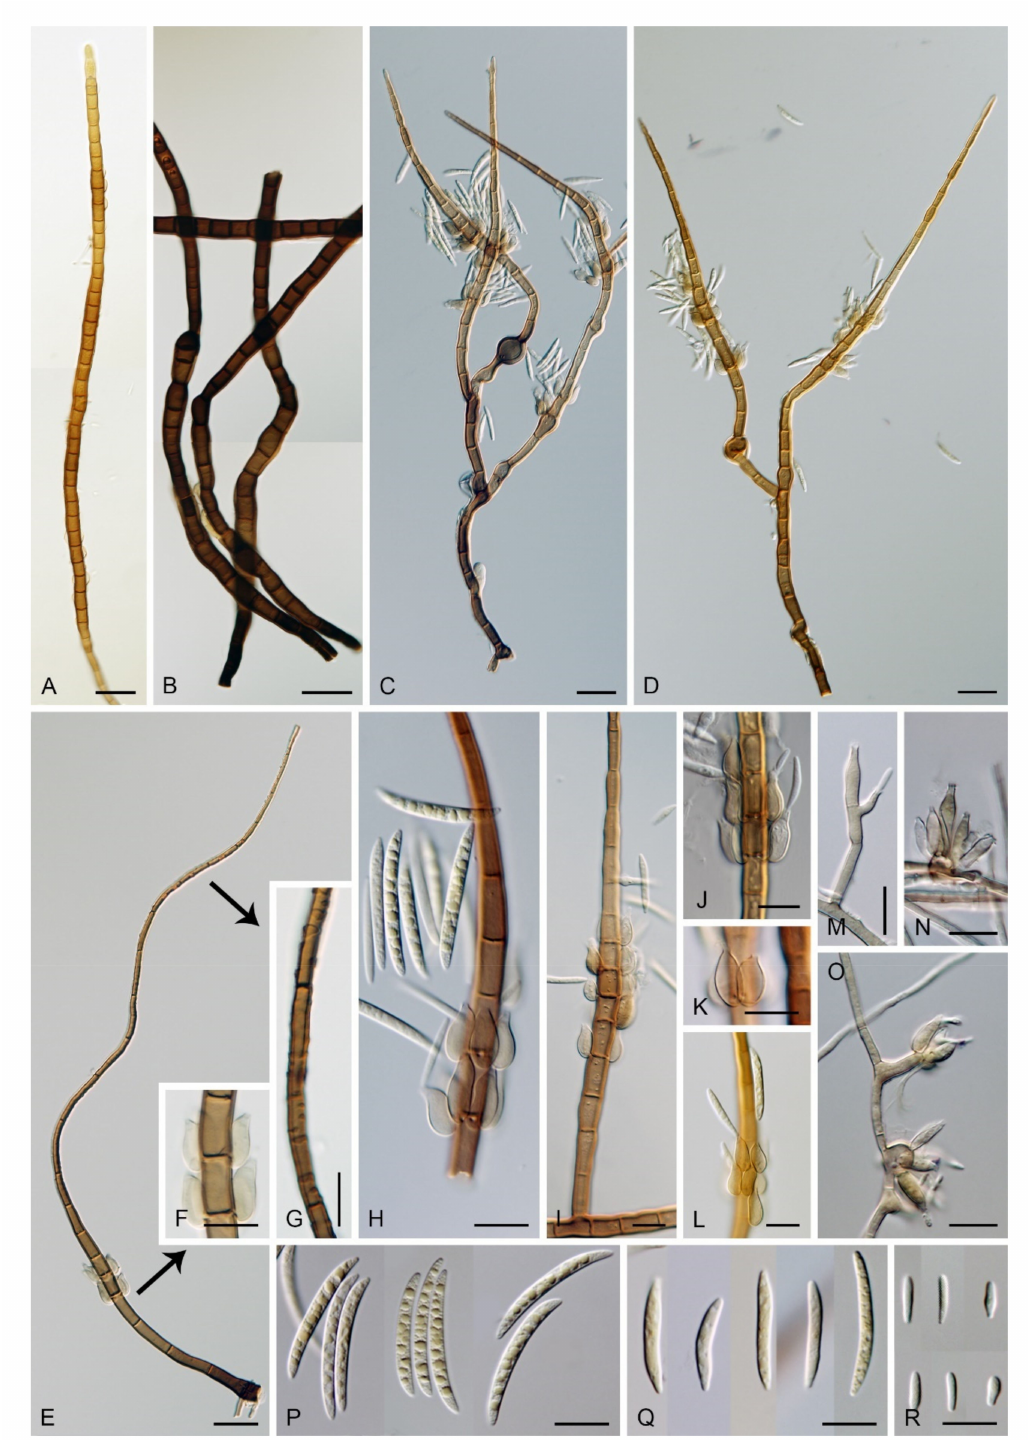
Figure 16. Zanclospora novae-zelandiae . ( A , B ) Stanjehughesia-like conidiophores. ( C – E ) Zanclospora conidiophores. ( F , H – L ) Conidiophores and branches with phialides in whorls. ( G ) Apical, setiform part of the conidiophore with excrescences, in detail. ( M – O ) Single phialides or less complex conidiophores with phialides in verticillate arrangement. ( P , Q ) Macroconidia. ( R ) Microconidia. Images: ( A , C , D , I – L , Q ) on CMA with U. dioica stems after 3 months; ( B , E – H , P ) on the natural substrate; ( M – O , R ) on MLA after 6 weeks; ( A , C , D , I – L , M – O , Q , R ) from ICMP 15781 (ex-epitype); ( B , E – H , P ) from PDD 80663. Bars: ( A – E ) = 20 µ m; ( F – R ) = 10 µ